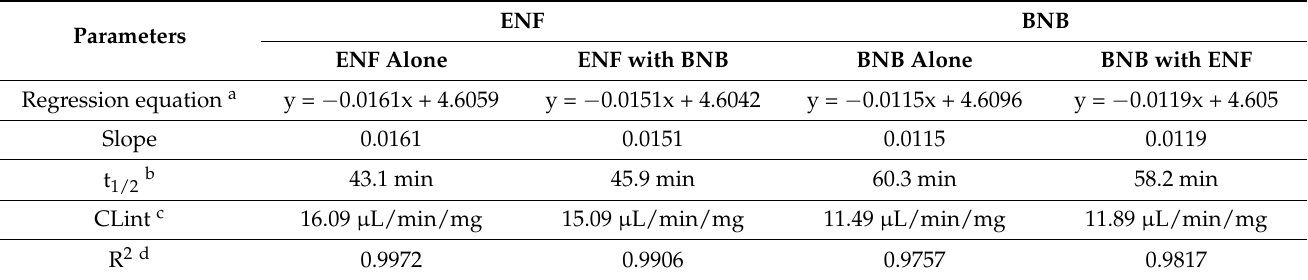
Figure 7. Metabolic stability curves of ENF alone and in a mixture with BNB ( A ) and BNB alone and in mixture with ENF ( B ). Table 5. ENF and BNB metabolic stability parameters after incubation with